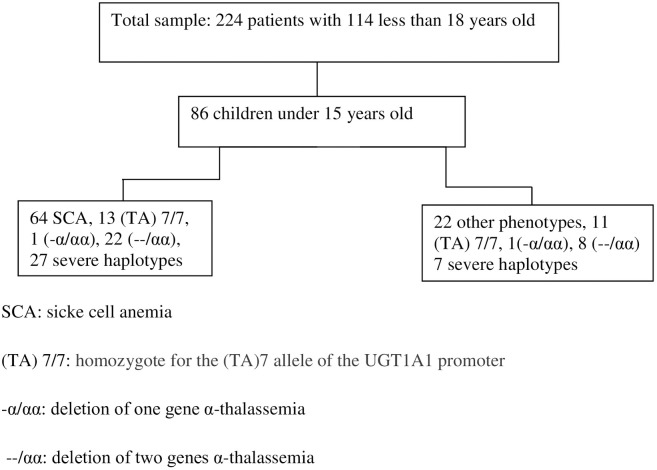
Flow chart of the distribution of the study patients.